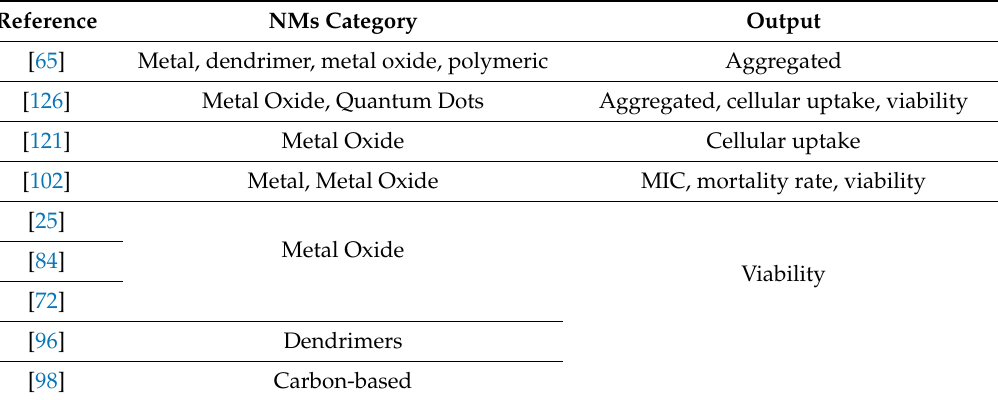
Table 8. Endpoints predicted by the ensemble extracted from the studies